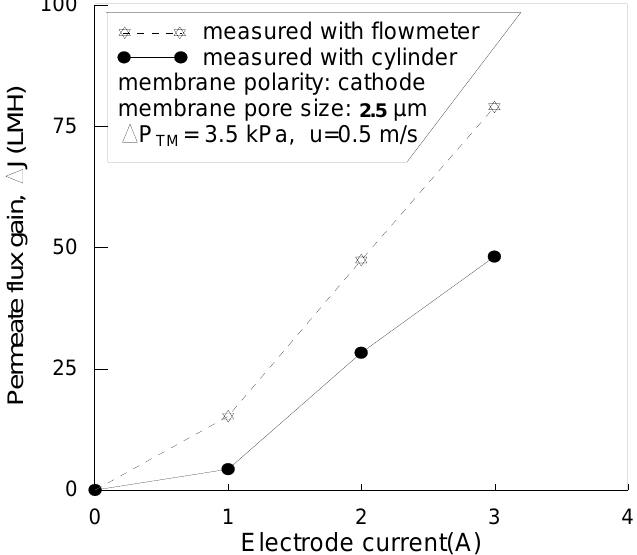
Figure 5. The permeate flux gain Δ J varies with cathode current